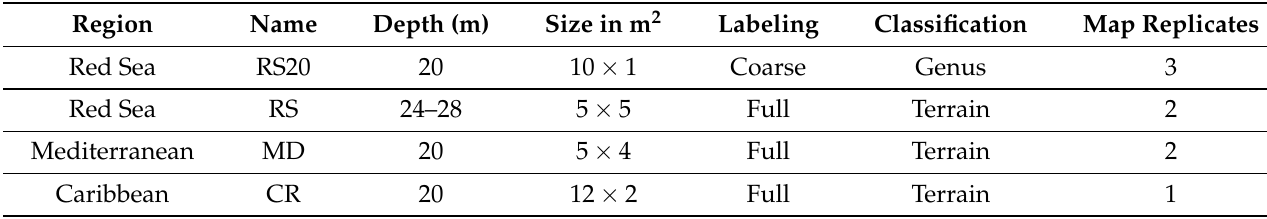
Figure 4. [Top] The global distribution of the three study zones, and the main photomosaics used in this study; the benthos data-set [bottom], (Table 1). ( A ) Spartan Reef offshore Haifa on the eastern Mediterranean coastline ( MD data-set). ( B ) IUI of Eilat reef, Gulf of Aqaba, northern Red-Sea ( RS and RS20 data-sets). ( C ) Double-Wreck reef, island of St. Eustatius in the eastern Caribbean ( CR data-set). Table 1. The different data-sets used in this study are from three oceanic regions. Some of the data-sets are labeled coarsely (not all pixels have a label) and some are manually segmented (full manual labeling; every pixel has a label). Classification is divided between a genus-specific scheme and a lower level habitat-mapping scheme (Terrain) with eight classess that represent the terrain